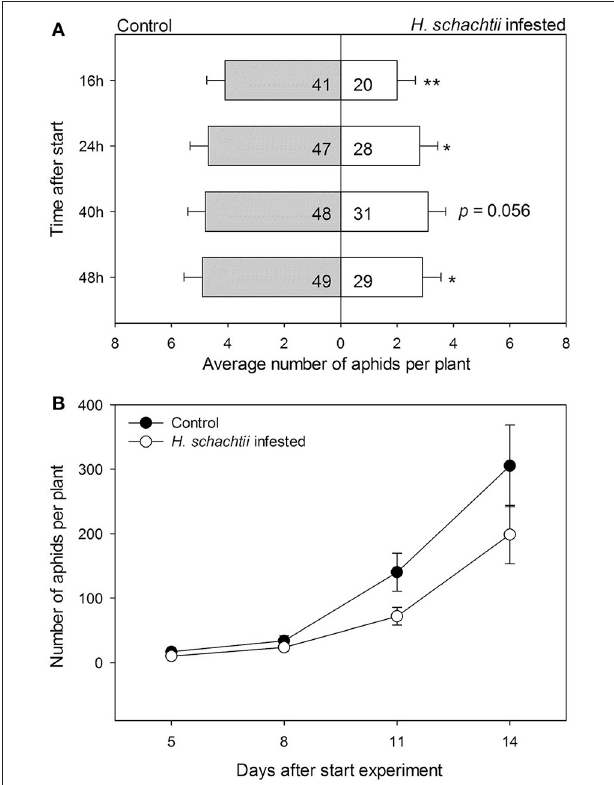
FIGURE 2 | Average numbers ( ± SEM) of Brevicoryne brassicae aphids found per plant. (A) Number of aphids at 16, 24, 40, and 48h after 10 winged aphids were released in each cage ( n = 10). The aphids were allowed to choose between a control plant (gray bars) and a plant infested with Heterodera schachtii nematodes (white bars) enclosed in a single cage. In the bars: sum of aphids out of 100 released in total found on plants in the respective treatment group. The remaining aphids were not found on any plant at the times the aphids were counted. The asterisks indicate whether the distributions of the aphids overall were deviating from a 1:1 distribution (replicated G -test per time point, Gpooled, d.f. = 1); * p < 0.05, ** p < 0.01. (B) Numbers of aphids on either plant from 5 to 14 days after aphids were released. Black circles: control plants, white circles: H. schachtii infested plants. Both plants were left in the same insect cage over the course of the experiment; the resulting numbers thus are a combination of growth rates and redistribution of